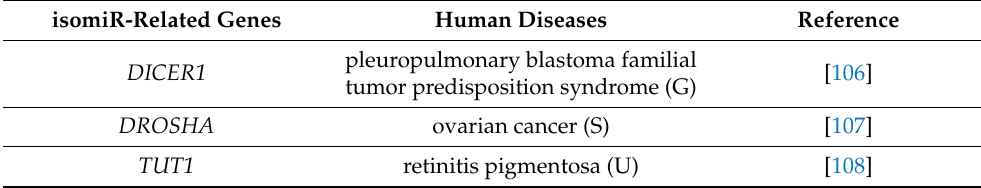
Table 2. IsomiR-related genes and human